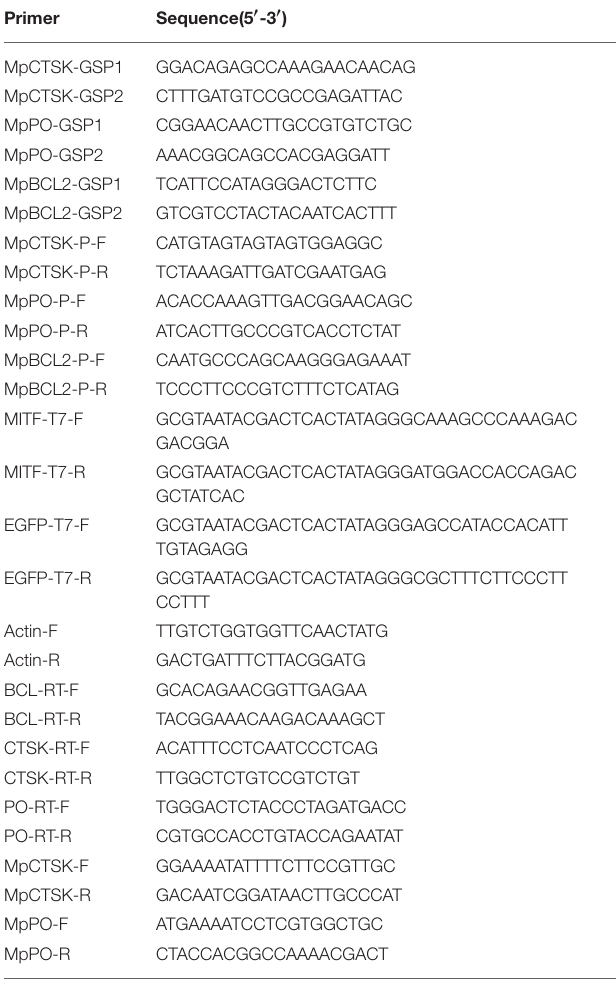
TABLE 1 | Sequences of the primers used in this study.